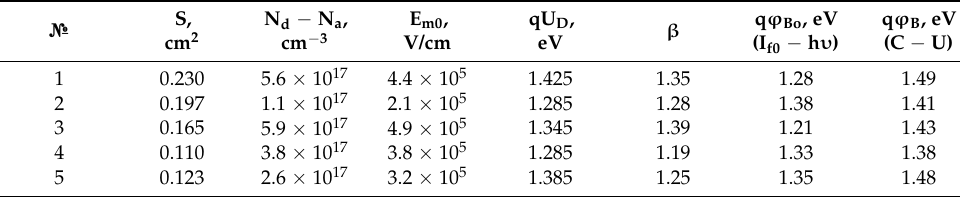
Table 1. Parameters of BS energy diagrams of Au-Pd-n-GaP at T = 300